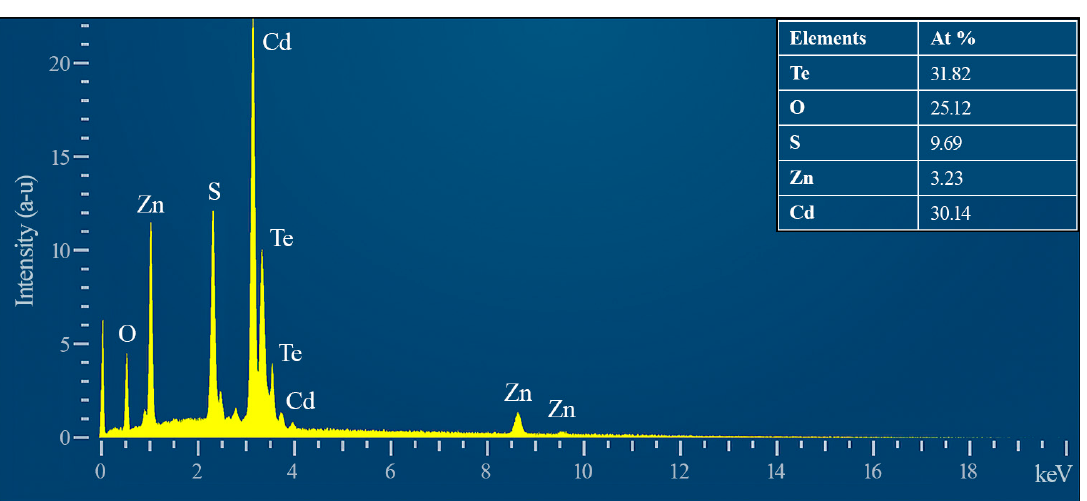
Figure 3. SEM images of the surface CdxTeyOz/CdS/ZnO heterostructure showing pinholes on the surface: ( a ) 1300× magni fi cation shows the surface interface, ( b ) magni fi cation of 108,514× shows the micromorphology of the surface.